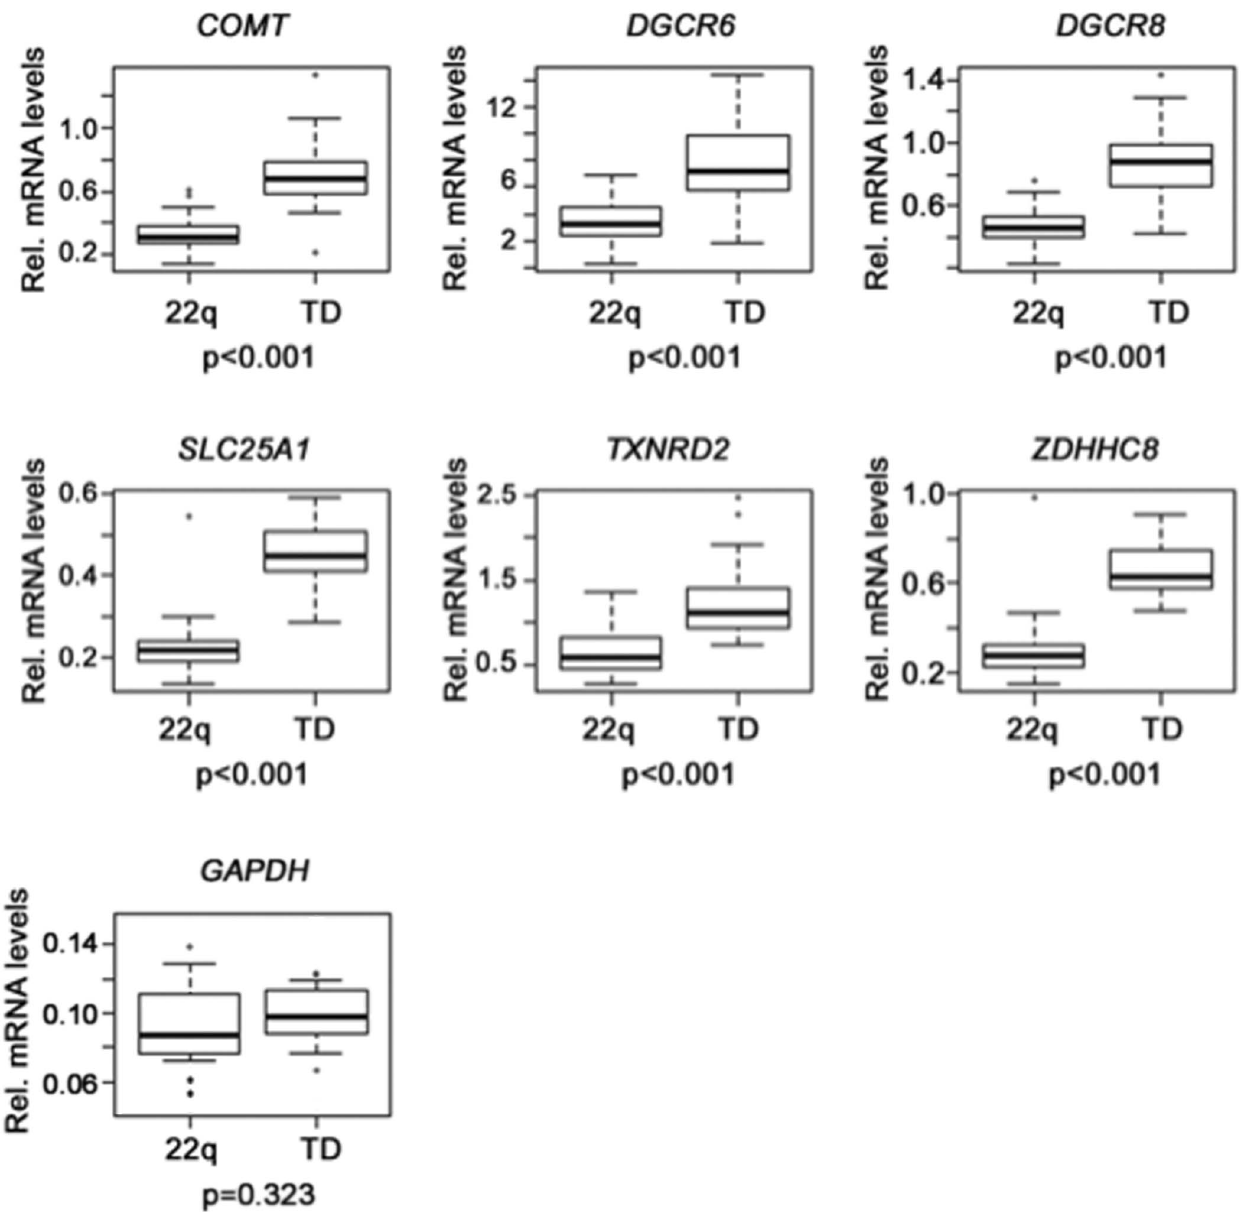
Figure 2. Gene expression levels. Box plots showing the relative transcript expression levels for six genes mapping within the deleted region and of the GAPDH gene, used as control. Total RNA was isolated from 90 individuals with 22q11DS (22q) and from 40 typical developing age-matched controls (TD). Error bars indicate standard errors. mRNA levels were normalized to the reference Glucuronidase gene. Respective p-values are shown.